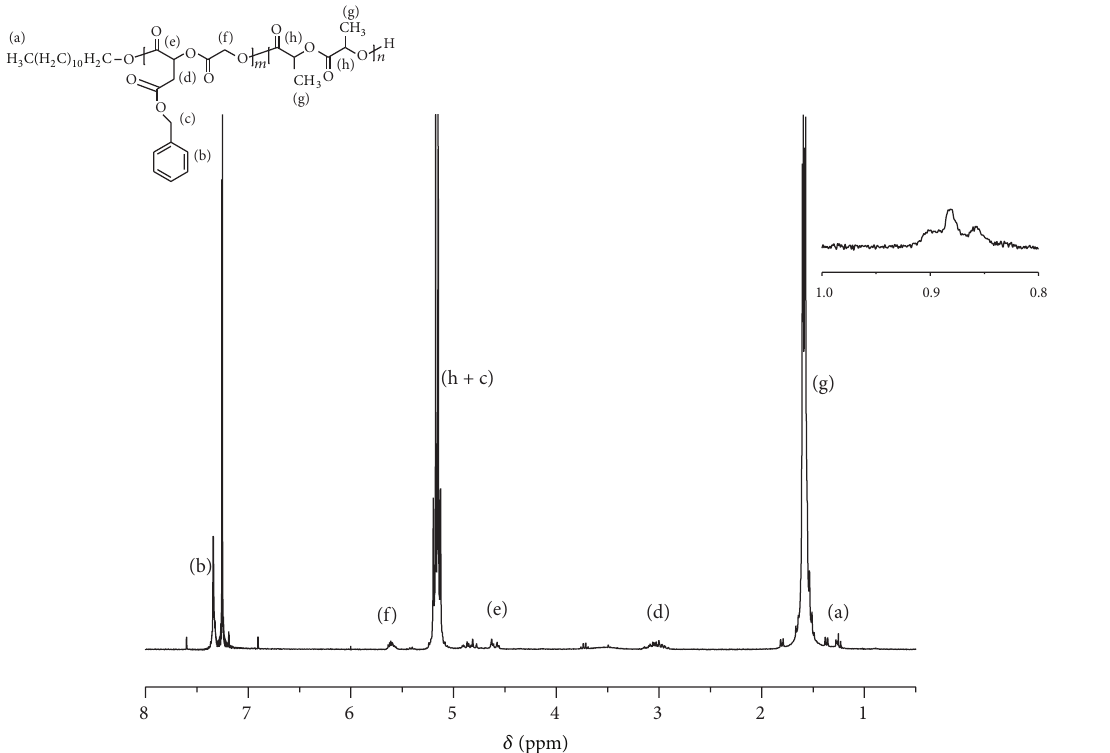
Figure 1: 1 H NMR spectrum of P(LA 92 - co -BMD 8 ) random copolymers (CDCl 3 ). Table 1: Polymerization of l-LA with BMD initiated by dodecanol and catalyzed with stannous octoate a . l-LA theo